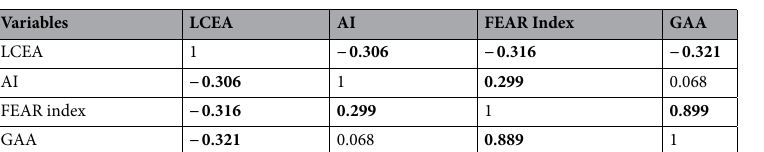
Table 3. Spearman correlation coefficients of the radiological measurements for all included hips a . a